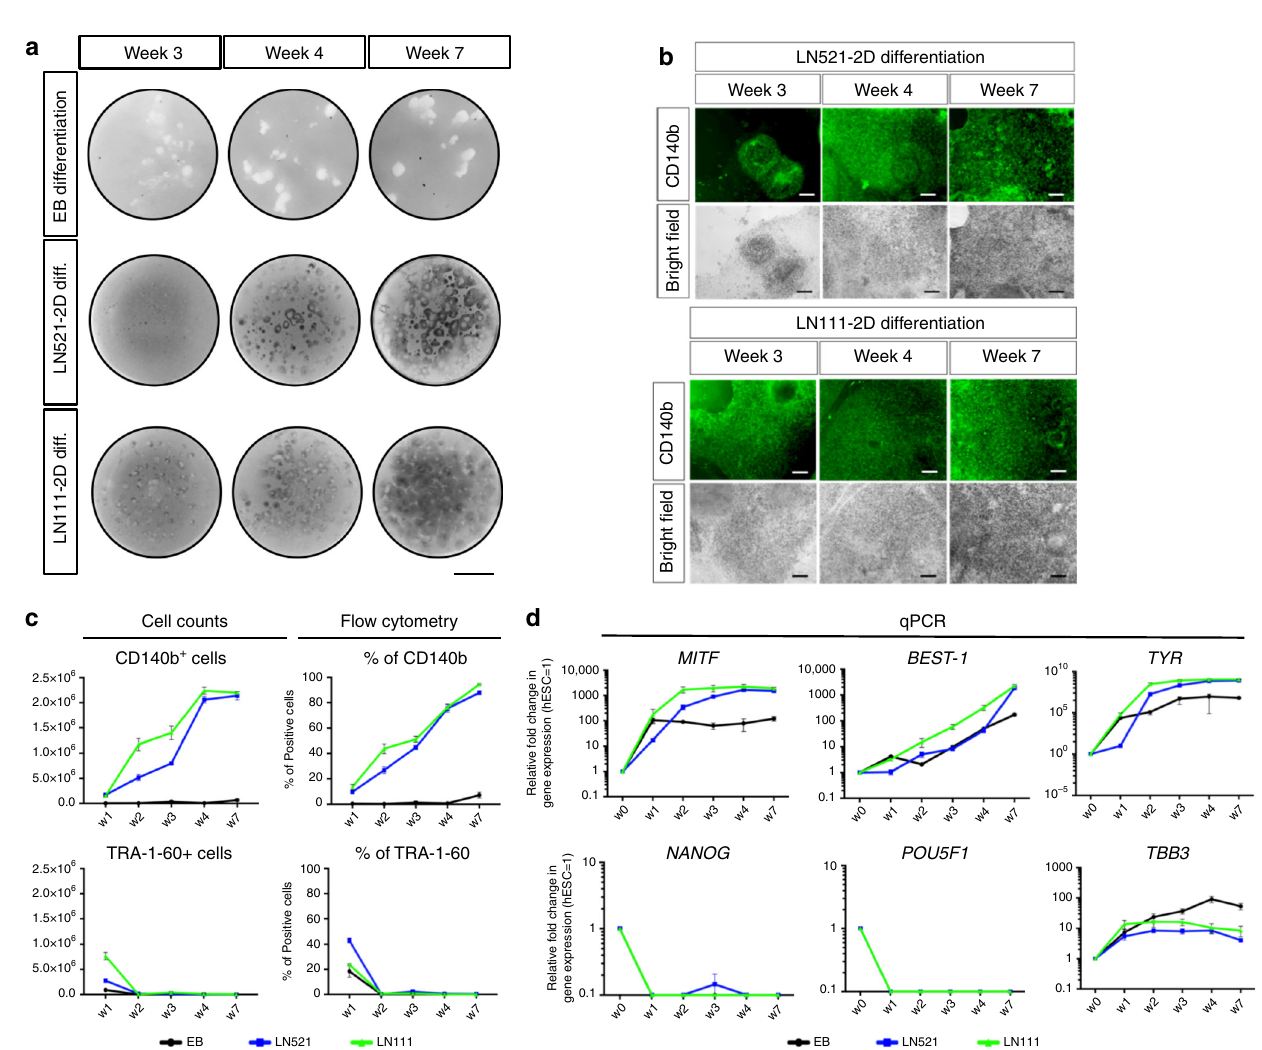
Fig. 2 hPSC-RPE induction in 2D using hrLN-111 and hrLN-521. a Camera pictures showing the progression of the differentiation (note pigmentation, weeks 3 – 7) in suspension cultures (embryonic bodies, EB) and 2D in both hrLN-111 and hrLN-521. b Bright fi eld and immuno fl uorescence pictures showing the increase of CD140b expression and pigmentation level during the time course of 2D hPSC-RPE differentiation on hrLN-521 and hrLN-111. c Charts comparing the yield and percentage of positive cells, measured by fl ow cytometry, for CD140b and TRA-1-60 during the time course of hPSC-RPE differentiation among the three different protocols tested (embryoid bodies, hrLN-521 and hrLN-111). d Gene expression analysis of pluripotency and RPE- speci fi c genes throughout the time course showed in a . Values are normalized to GAPDH and displayed as relative to undifferentiated hESC. Bars represent means ± SEM from three independent experiments. Scale bars: a = 5 mm; b = 100 μ m. Source data are provided as a Source Data fi le.